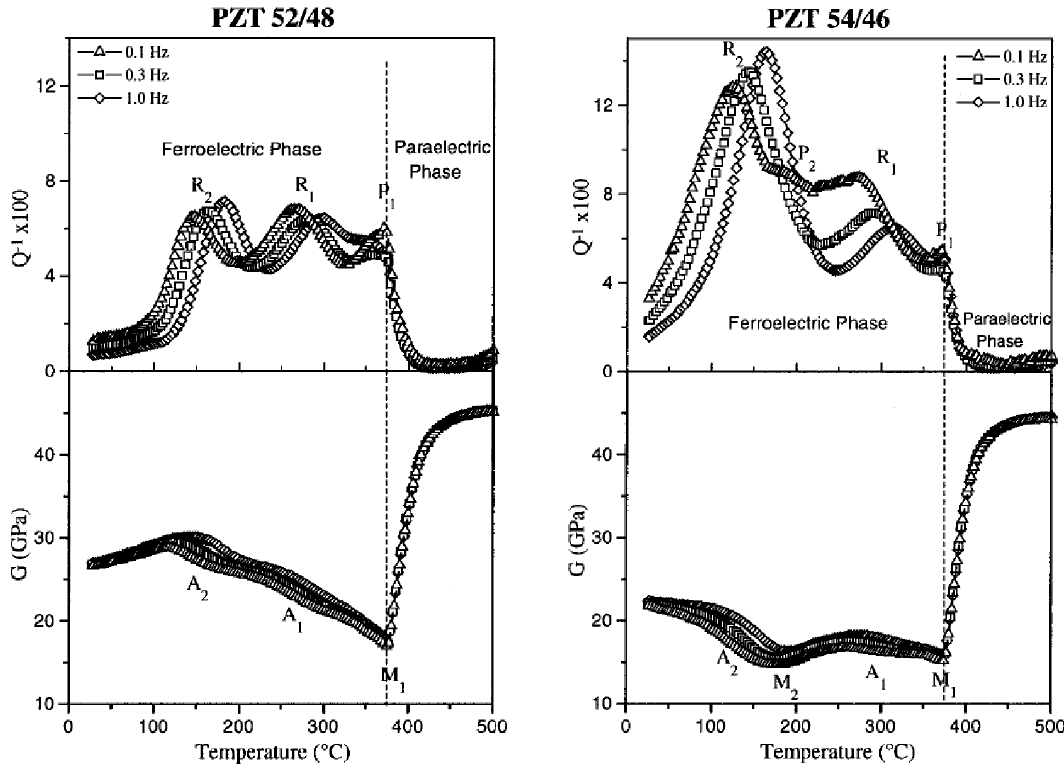
Figure 10. Shear modulus G and elastic energy loss coefficient Q − 1 of PZT-48 and PZT-46 measured at 0.1, 0.3 and 1 Hz. (from Ref. [135], Copyright American Institute of